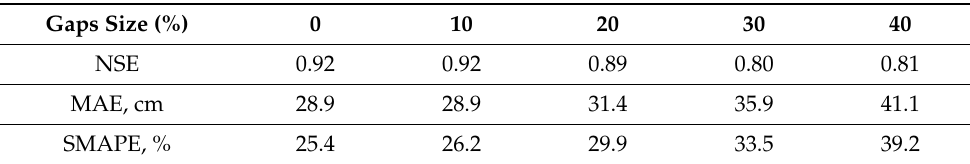
Table 7. Dependence of the forecast error on the gap size in the training sample for ensemble model. Metrics are shown for test